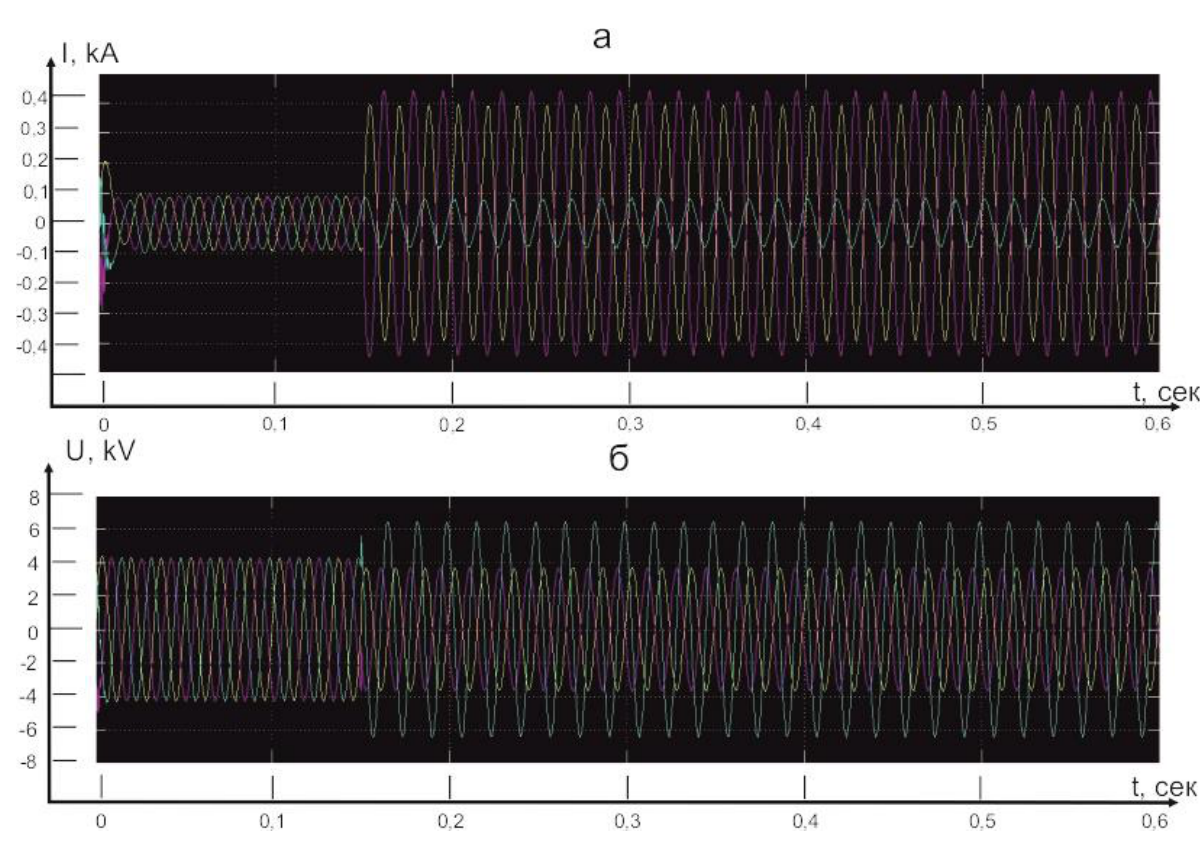
Figure 7. The oscillogram of current (a) and voltage of network (b) in the case of double phase closed –circuit fault through the transition resistance 10 ohm was